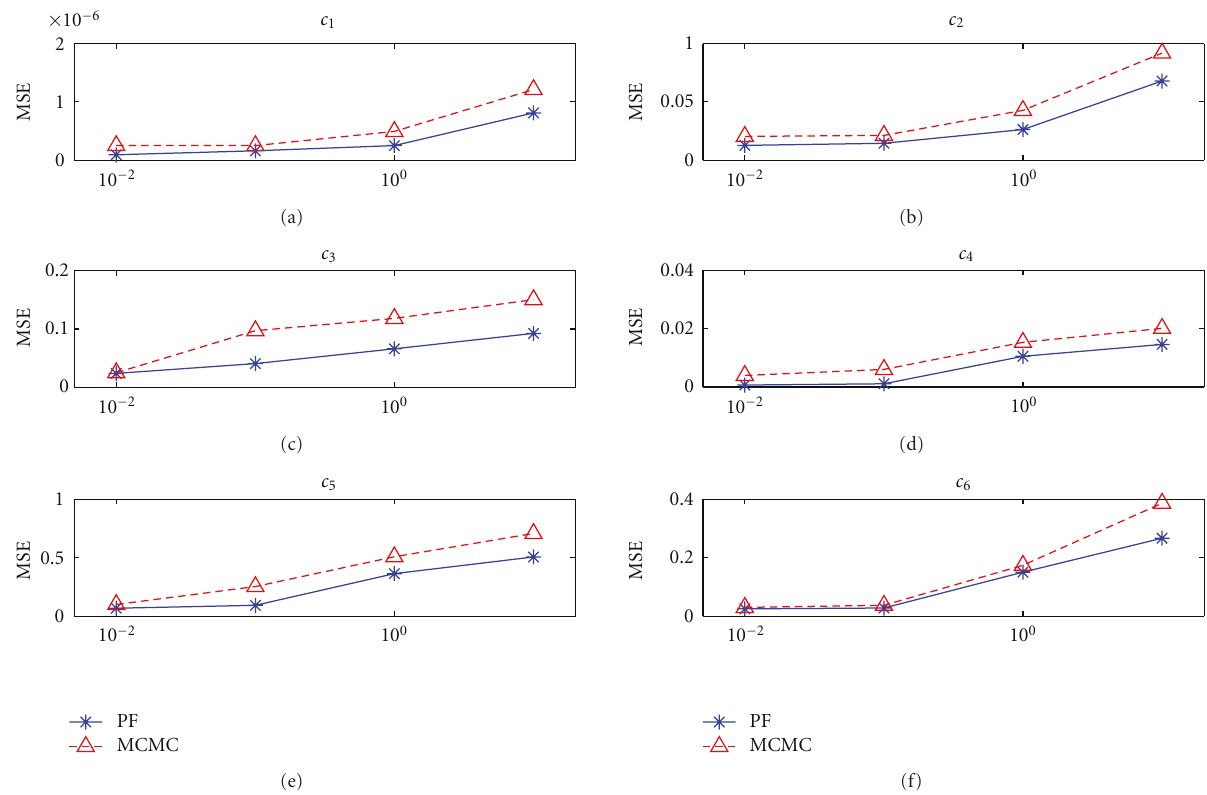
Figure 2: The mean-square-error performance comparison between Algorithm 1 (particle filter) and Algorithm 2 (MCMC) as a function of the variance of the observation noise σ 2 ( N s = 2 × 10 4 , m = 15, N = 40, Σ = σ 2 I